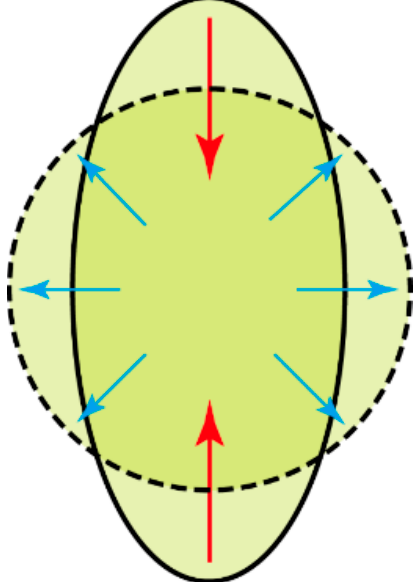
Figure 4. A long, narrow graph can be flattened to become rounder, making the area larger and the circumference unchanged.